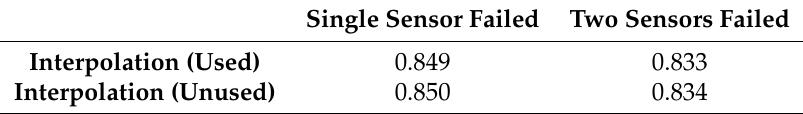
Table 2. Performance comparison of forecasting for high-energy electron flux 24 h ahead. Each cell in the table shows a prediction success rate where the credibility threshold is 0.5. The sensor E 24 alarms if its credibility is less than or equal the